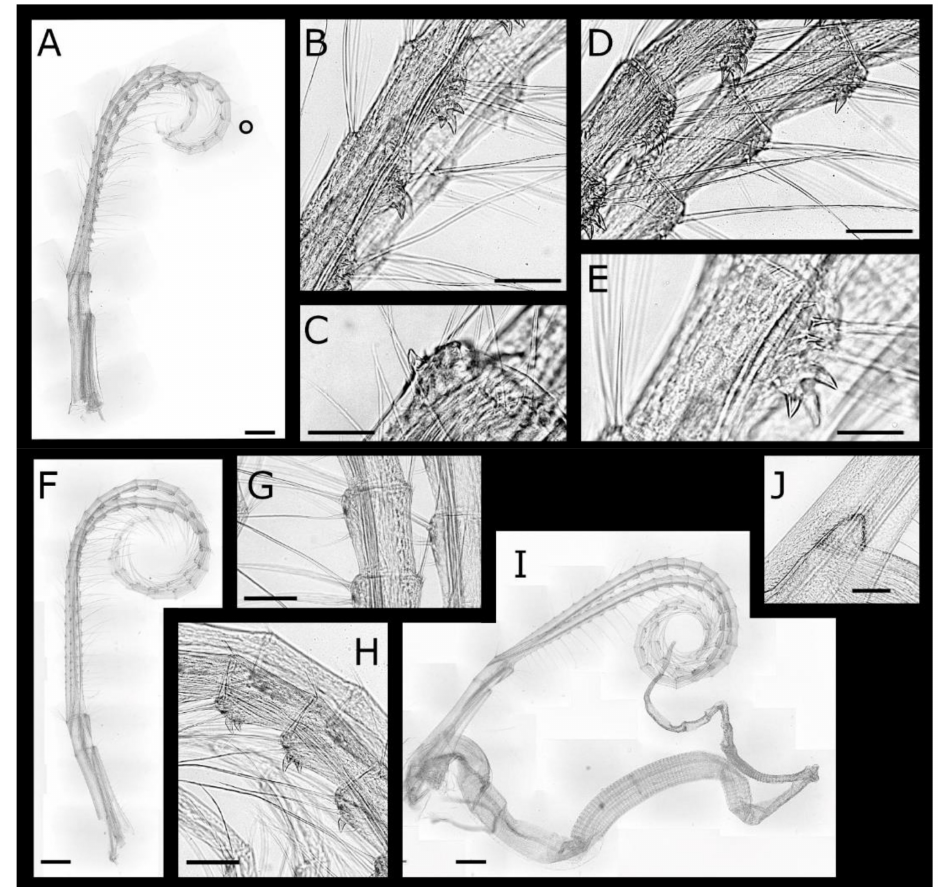
Figure 4. Acasta caveata sp. nov. cirri IV–VI (all WAM C67716, holotype). ( A ) left cirrus IV; ( B ) hooked teeth on medial segments of left cirrus IV anterior ramus; ( C ) close up of tooth on basis of right cirrus IV protopod; ( D ) medial segments of cirrus IV; ( E ) detail of erect spines on medial segments of cirrus IV anterior ramus; ( F ) cirrus V; ( G ) setae on medial segments of cirrus V; ( H ) hooked teeth on medial segments of cirrus V anterior ramus; ( I ) cirrus VI and penis; ( J ) basidorsal point of penis. Scale bars: A, F, I = 300 µ m; B, D = 100 µ m; C, E = 50 µ m; J = 200 µ